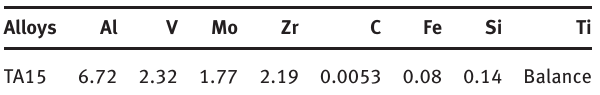
Table 1: Chemical composition of the Ti – 6.5Al – 2Zr-1Mo-1V titanium alloy (wt.%).